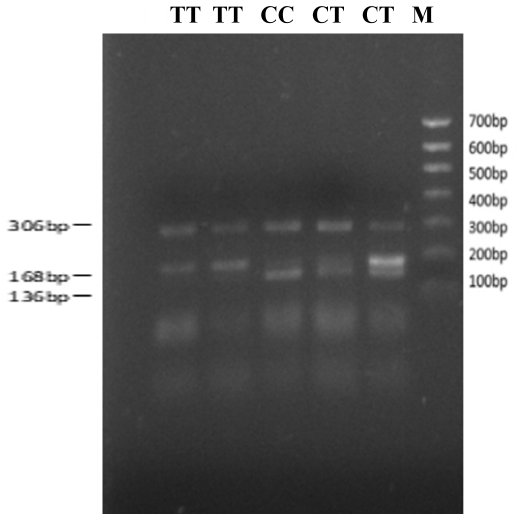
Figure 2. The result of T-ARMS-PCR with SNP: g.12454T > C Note that